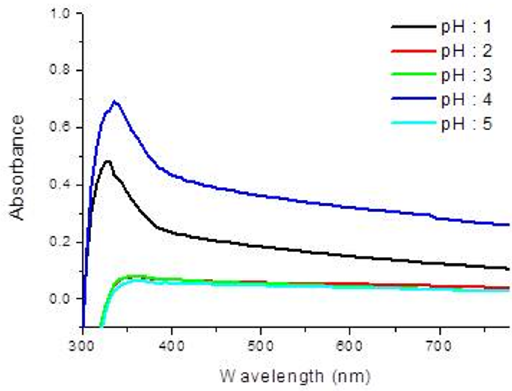
thin films produced at different pH. x